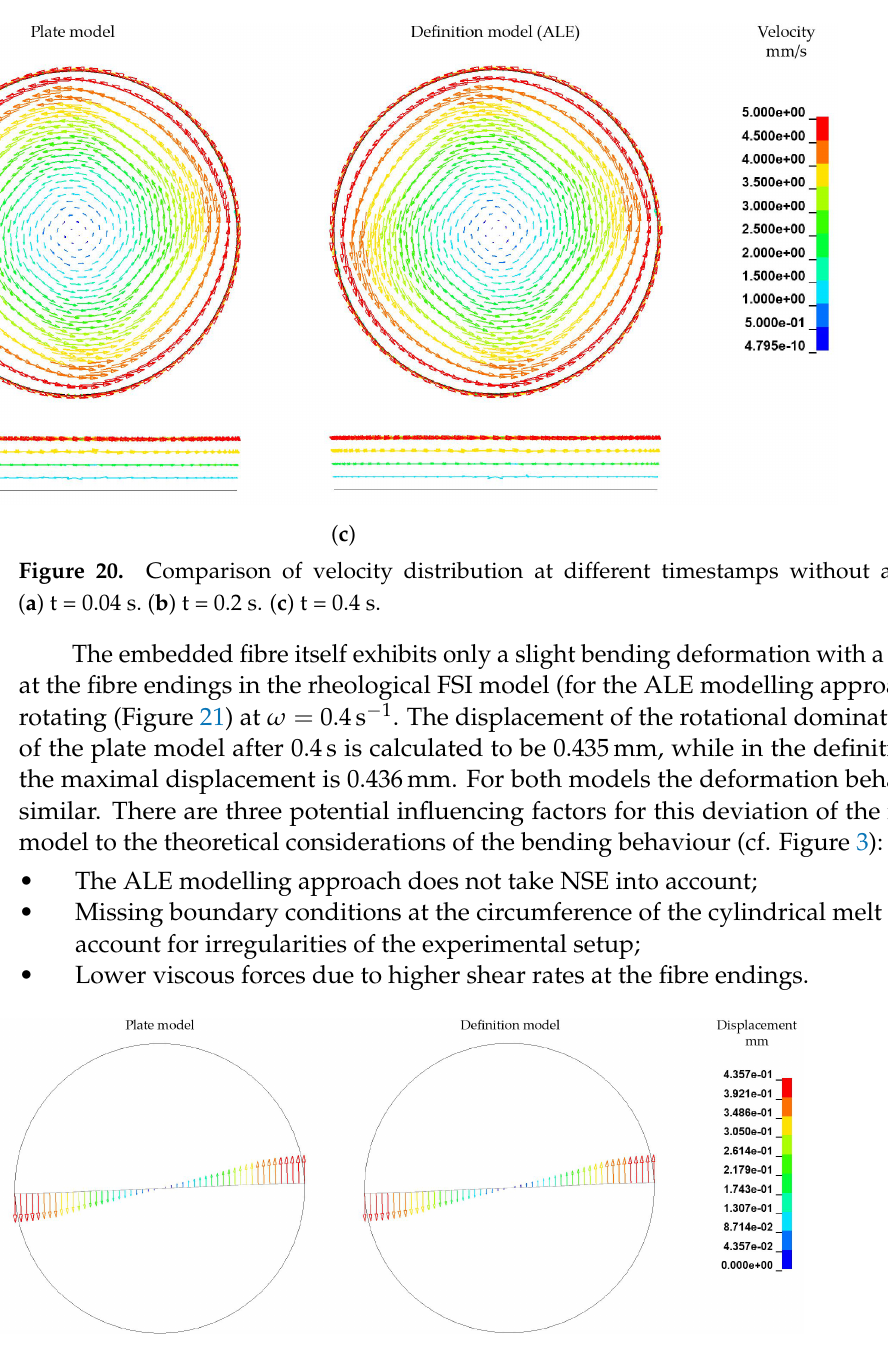
Figure 21. Comparison of fibre displacement and deformation with ALE approach after T = 0.4 s and ω = 0.4s −